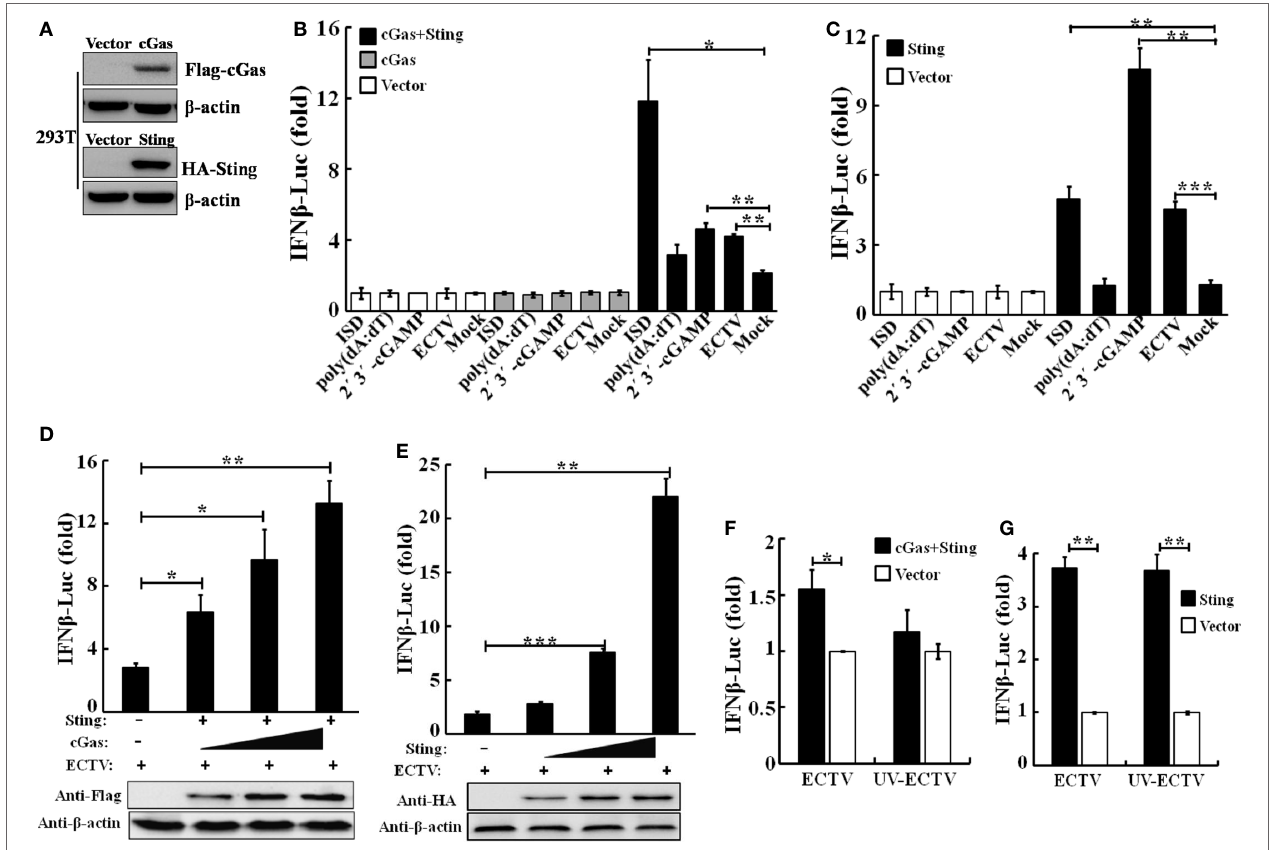
FigUre 1 | Sting and cGas are required for the induction of IFN- β during ectromelia virus (ECTV) infection. (a) Overexpressed cGas, Sting, and β -actin protein levels in HEK293T cells were evaluated by Western blot. HEK293T cells (1 × 10 5 ) were seeded in a 96-well plate and then were transfected with pRL-TK Renilla luciferase reporter plasmid (10 ng/well), IFN- β firefly luciferase reporter plasmids (100 ng/well), and together with cGas (100 ng/well), Sting (100 ng/well), cGas + Sting (50 ng per plasmid per well), or vector only (100 ng/well) (B,c) . After a 24-h transfection, cells were either stimulated with poly(dA:dT)/LyoVec (2 μ g/mL), ISD/LyoVec (1 μ g/mL), 2 ′ 3 ′ -cGMP-AMP (cGAMP) (20 μ g/mL), or infected with ECTV (MOI of 1) for 15 h, respectively. Luciferase activity was determined using the Dual-Glo ® Luciferase Assay System. (D) HEK293T cells were transfected with Sting expressing plasmid (50 ng/well), and increasing doses of